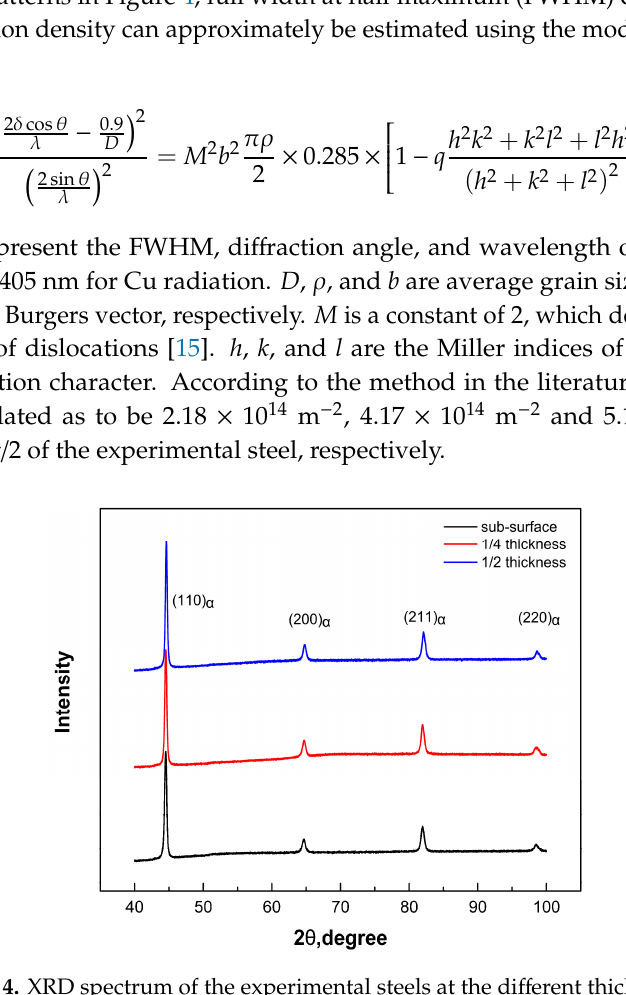
Figure 4. XRD spectrum of the experimental steels at the di ff erent